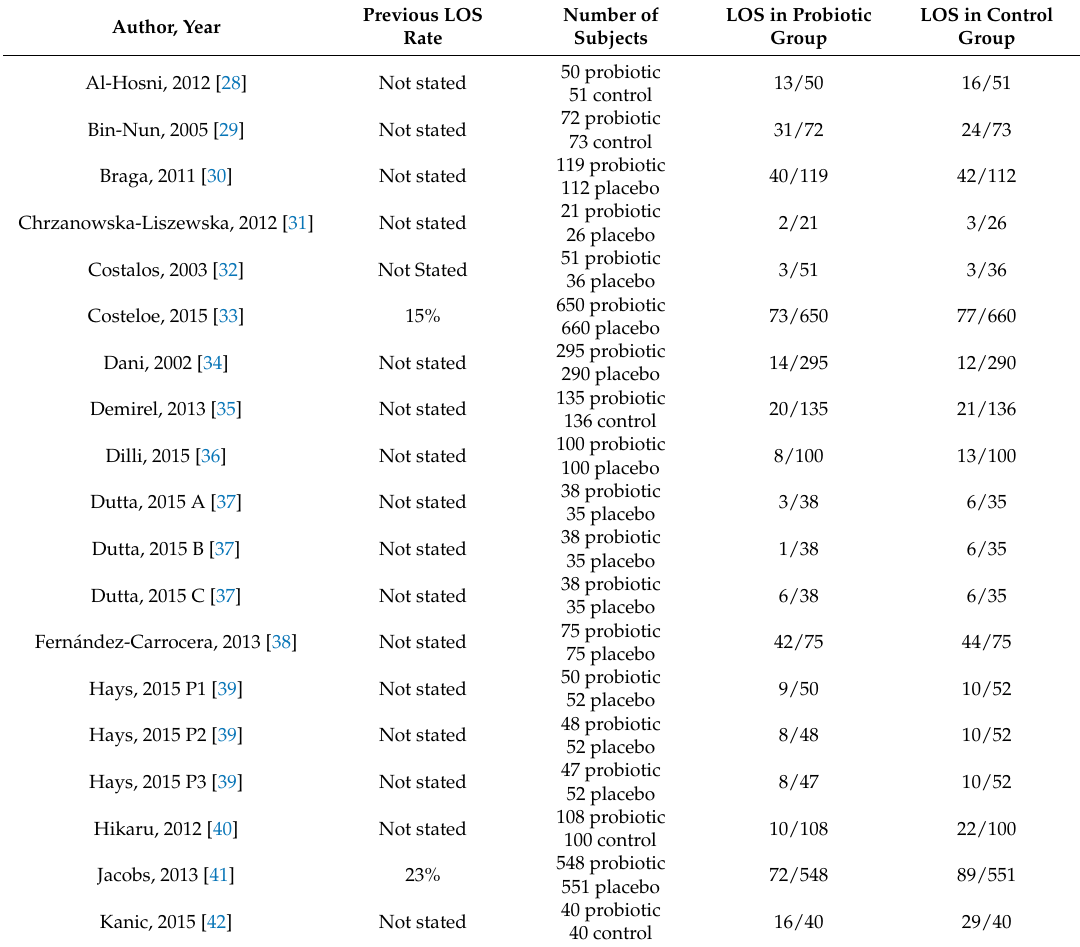
Table 3. Incidence of late-onset sepsis (LOS) in infants treated with probiotics and in